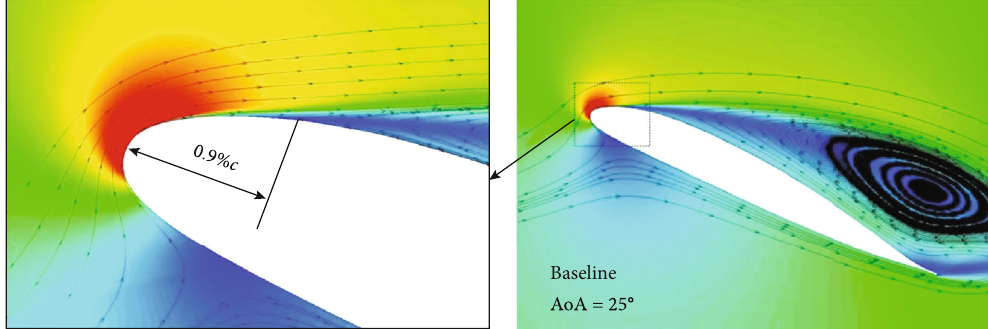
Figure 14: The position of fl ow separation at the leading edge of the airfoil (baseline, AoA = 25 °